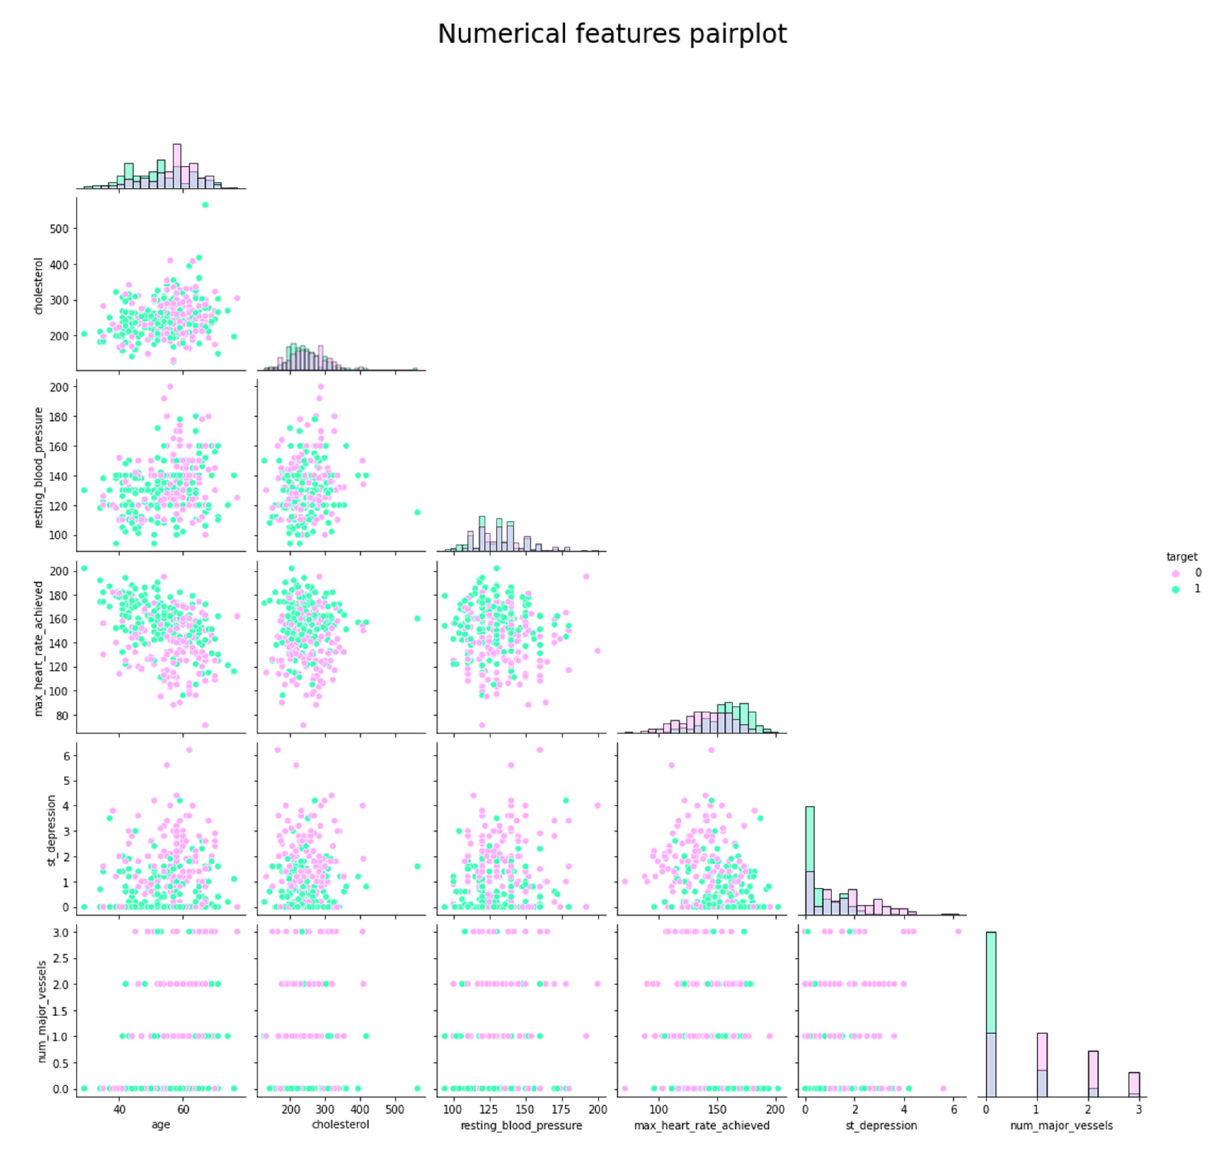
Figure 8. Numerical feature pair plots.